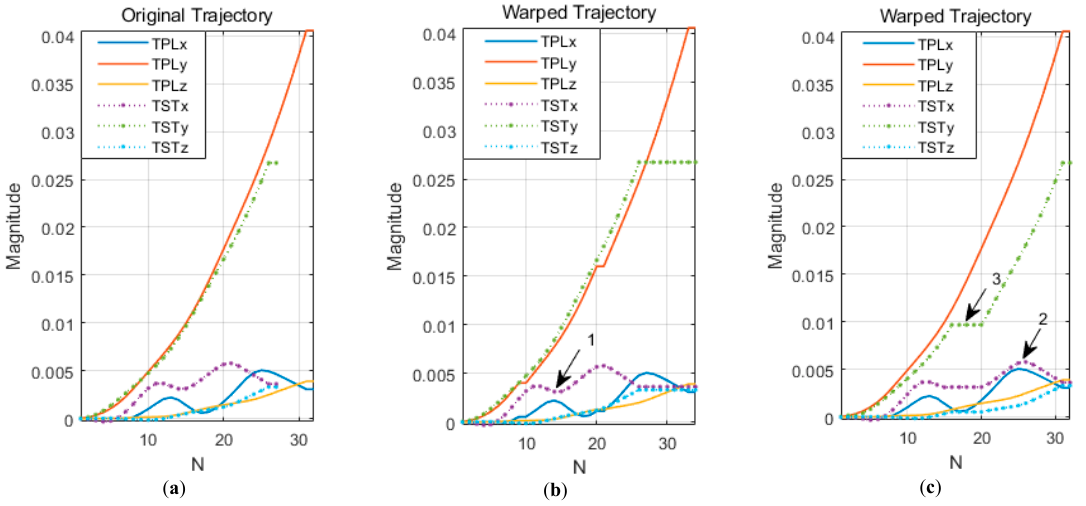
Figure 11. Expansions of the two output trajectory sequences on the time axis. ( a ) Input sequences, ( b ) output sequences of DTW, and ( c ) output sequences of GLR-DTW. ( b ) output sequences of DTW, and ( c ) output sequences of